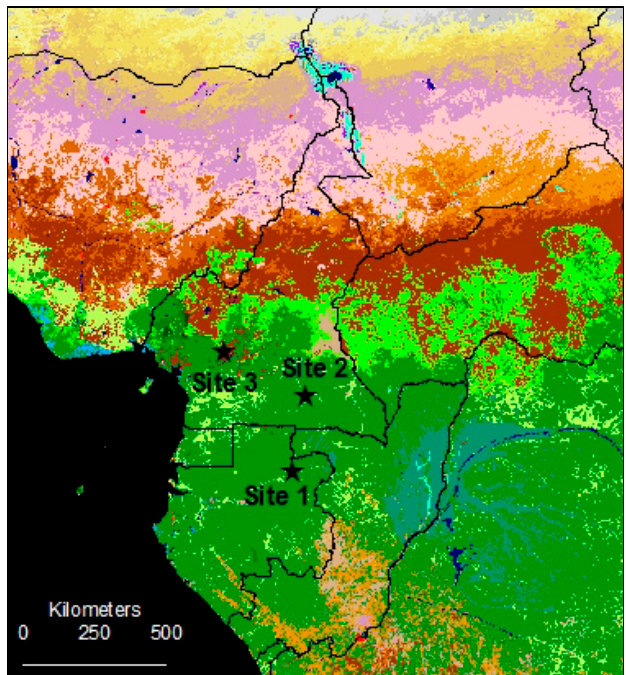
Figure 2. Location of the three study sites. Map adapted from Mayaux et al. [50].